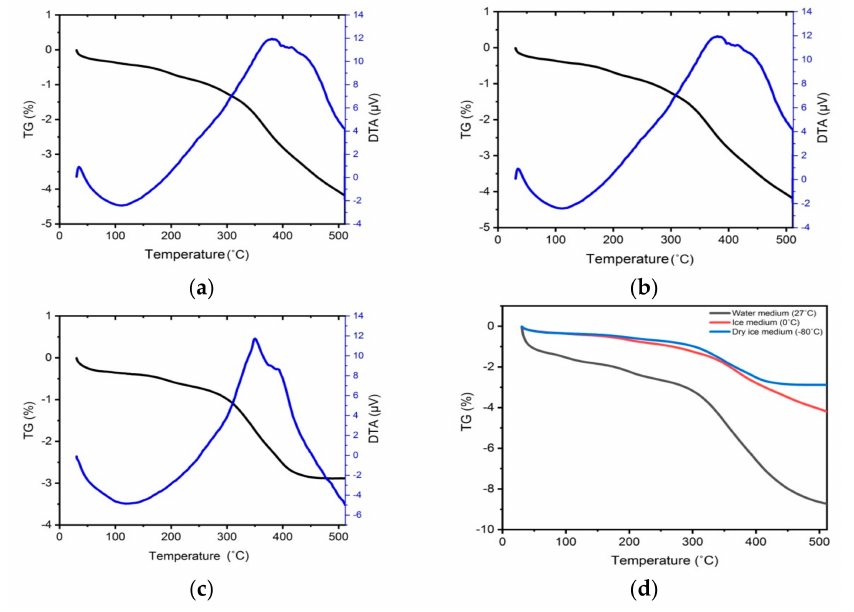
Figure 5. DTA/TGA AgNWs test results were quenched at temperature ( a ) 27 ◦ C, ( b ) 0 ◦ C, ( c ) − 80 ◦ C, and ( d ) comparison of the percentage of mass loss based on TGA